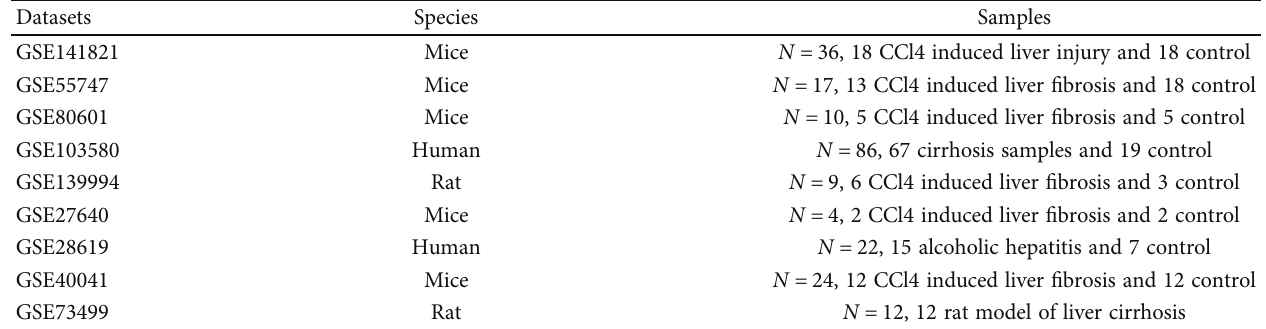
Table 1: The characteristics of the included